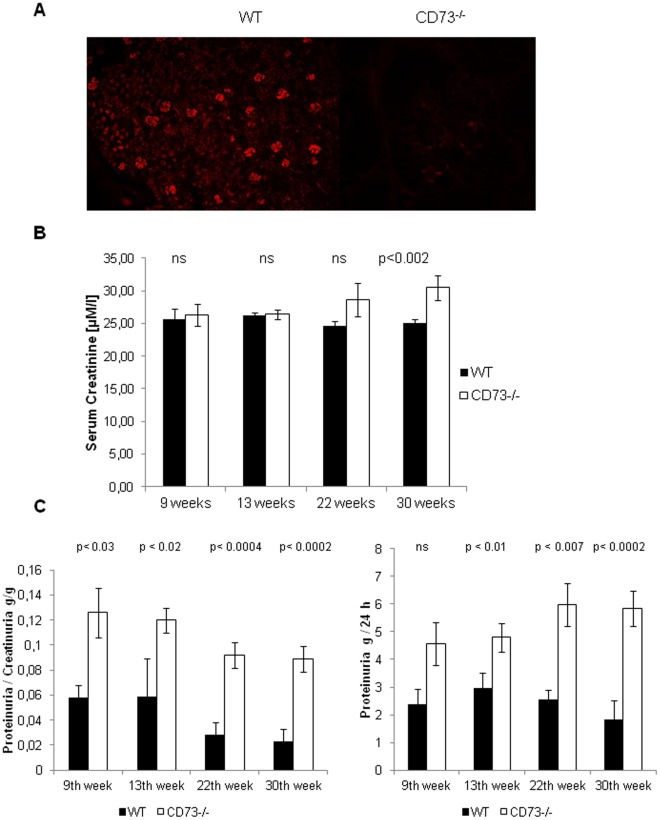
Increase of total proteinuria and decrease of renal function in mice lacking CD73.(A) Using immunohistochemistry with a CD73-specific antibody and a rhodamin red λ conjugated secondary antibody, confocal microscopy at a magnitude of 10× revealed staining of glomerular cells in the mesangium as well as peritubular cells in renal tissue of WT mice which is absent in the mutant. Images are representative of 3 of 5 animals with more than 2 sections per kidney. (B) Renal function estimated by the measurement of serum creatinine, auto normalized, in WT and CD73−/−mice. 8 to19 mice per group were used. Data are presented as means ± SEM, level of significance as indicated according to Student t-test. (C) Total proteinuria was elevated and increased with age in CD73−/−mice as compared to the wild type controls. We detected proteinuria/creatinuria in [g/g], left panel, and total urine protein in [mg/24h], right panel. 8 to 19 mice per group were used. Data are presented as means ± SEM, level of significance as indicated according to Student t-test.